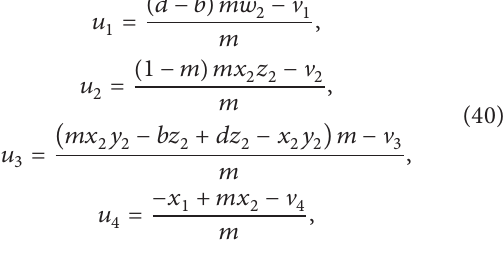
𝑤 1 (the dashed line) and